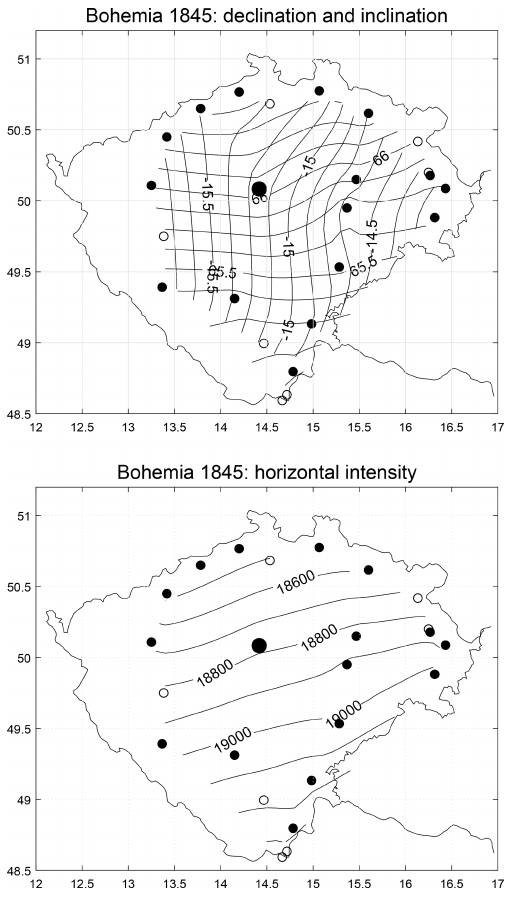
Figure 5. The contour maps for the magnetic declination (nearly vertical contours with values between − 14.25 and − 15.75 ◦ , where the minus sign shows that the declination was western at that time), the inclination (nearly horizontal contours with values between 65.125 and 66.375 ◦ ) and the horizontal intensity (nearly horizontal contours with values between 18500nT in the south and 19300nT in the north). The contours are based on Kreil’s original data. The observation locations are shown as circles, and the empty symbols denote points without inclination